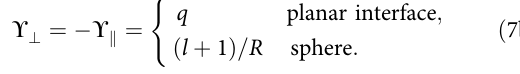
Figure 2e – h outline the plasmonic features of metal spheres as a function of their radii. In most respects, they mirror the qualitative conclusions drawn for the planar case, but with the